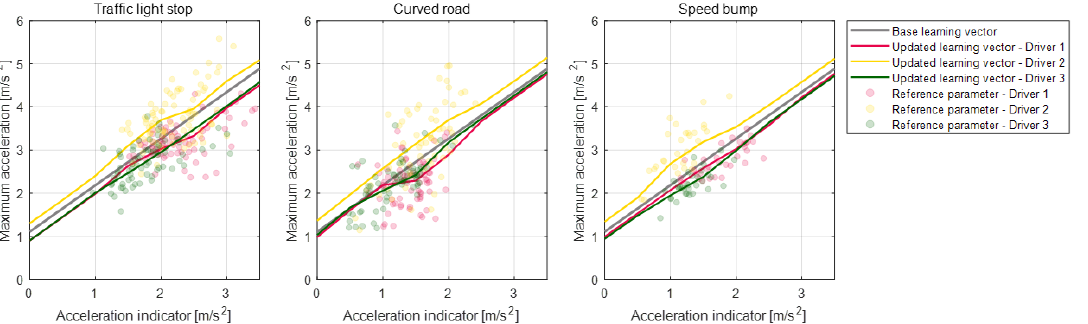
Figure 20. Learning results for parameter maximum acceleration for each road object.